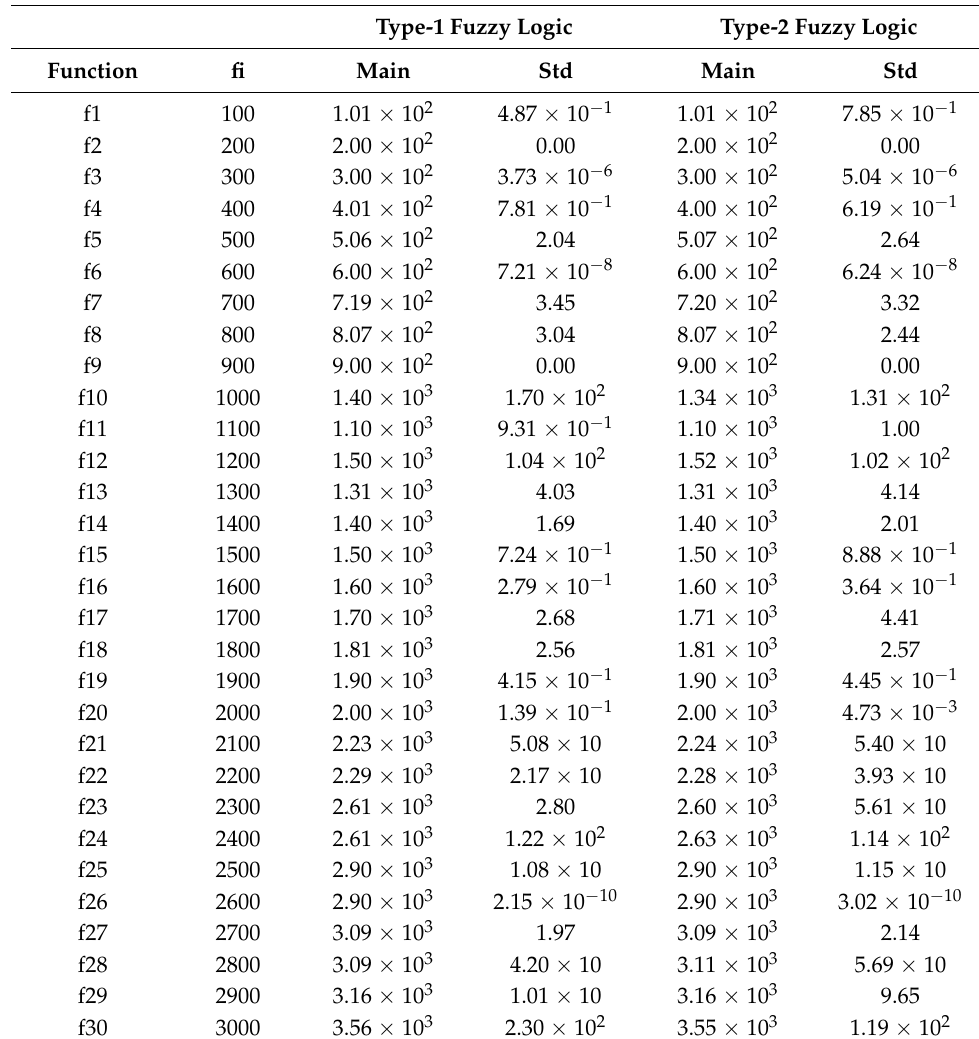
Table 2. Dynamic Stochastic Fractal Search (DSFS) results with 10 dimensions. Dynamic Stochastic Fractal Search (DSFS) with 10